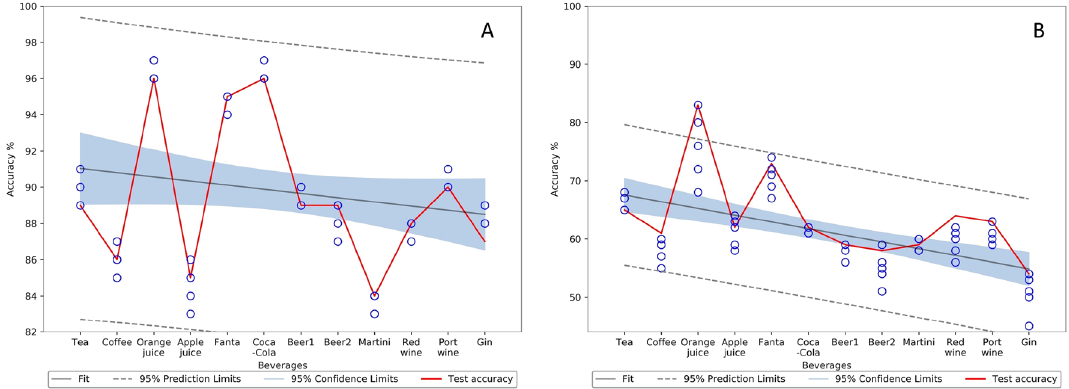
Figure 9. Paper3 confidence interval (CI) plot for beverage aging classification, ( A ) represents CI for SVM only and ( B ) represents CI for SVM with encoder.